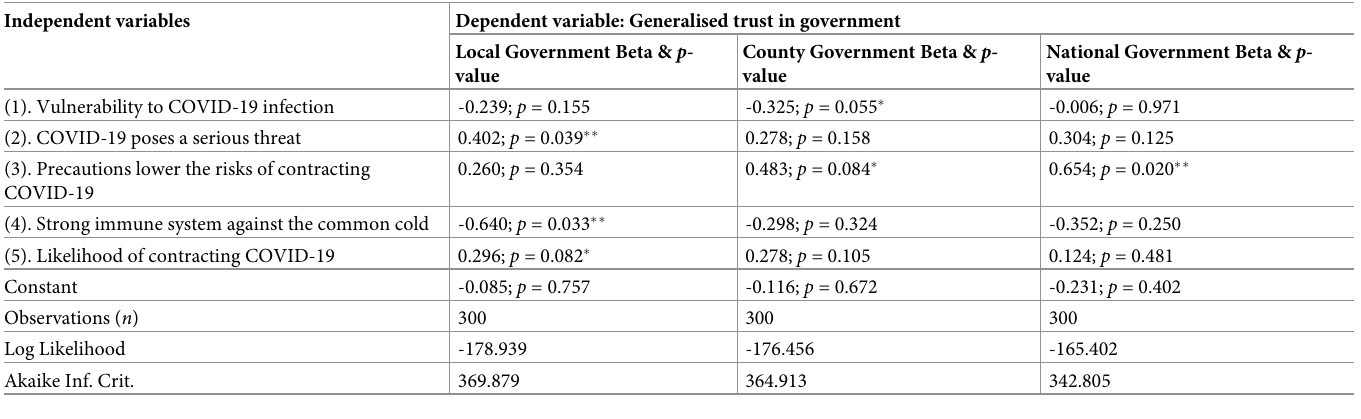
Table 9. COVID-19 perceived risks among self-confirmed CHVs (Probit